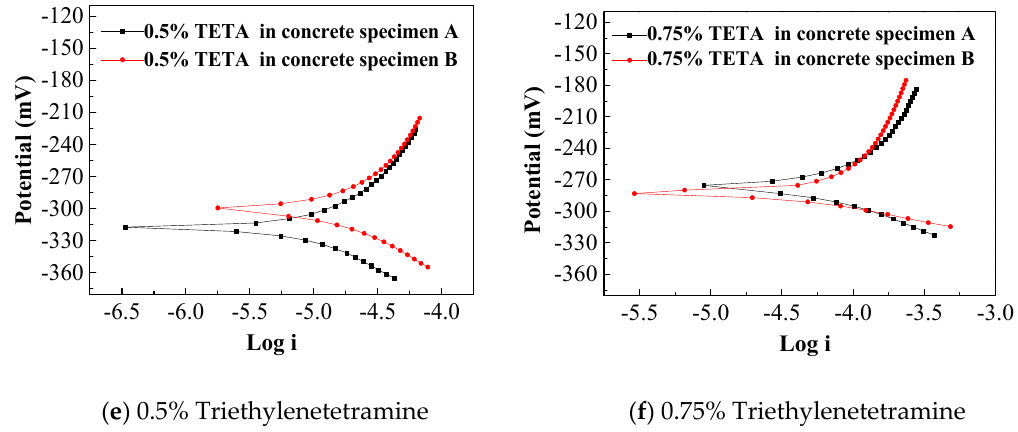
Figure 6. Polarization curves of a steel bar with a low concentration of inhibitor.